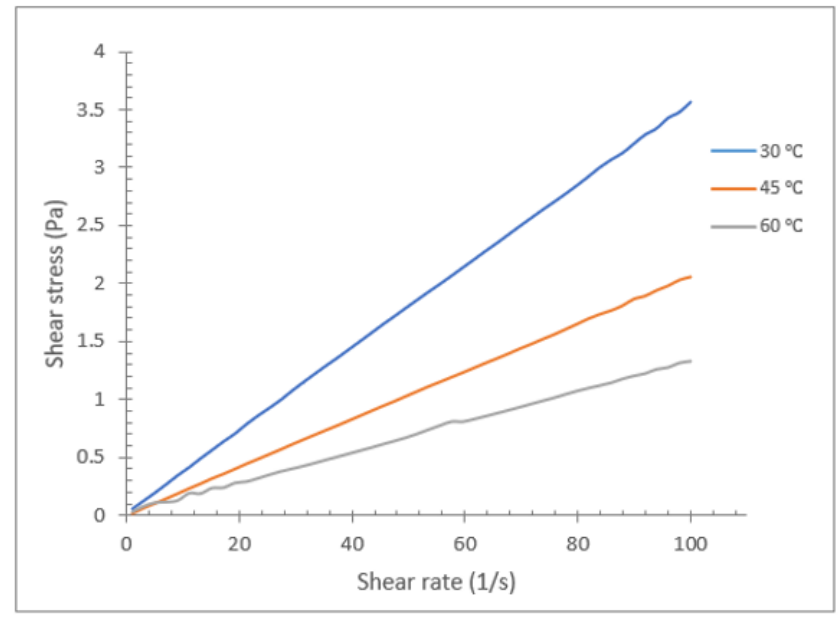
Figure 13. Rheological behavior of coconut oil/Al 2 O 3 -TiO 2 hybrid nanofluid (0.2%).